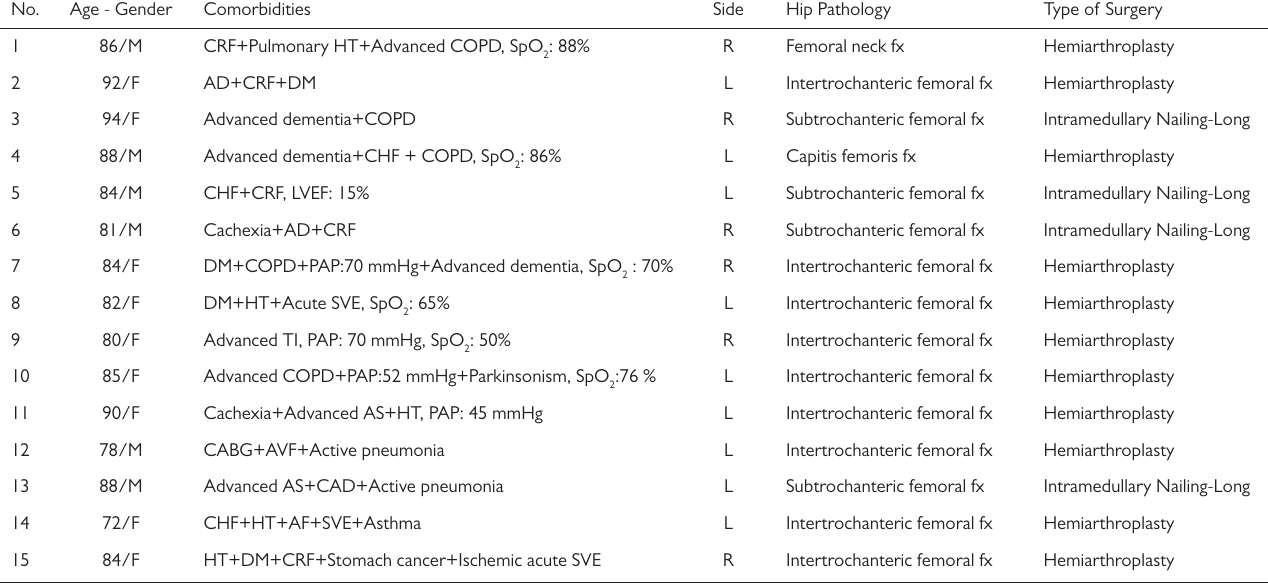
18 • Ahiskalioglu et al. Lumbar Erector Spinae Plane Block for Hip Table 1. Age, gender, comorbidities, side of surgery, hip pathology, and type of surgery for all patients No. Age - Gender Comorbidities Side Hip Pathology